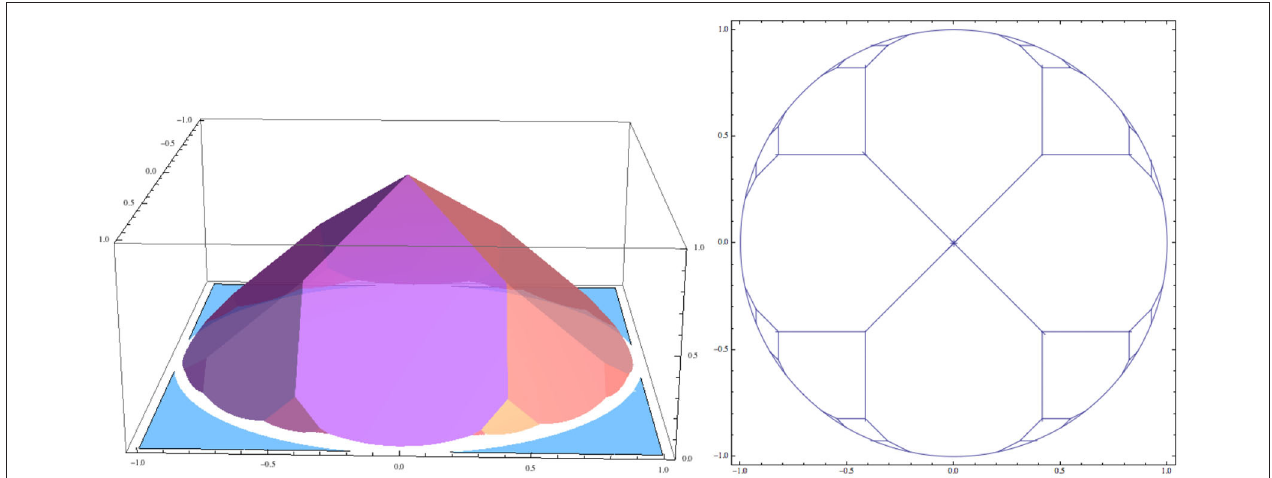
FIGURE 5 | An (cid:127) -tropical series and the corresponding (cid:127) -tropical curve.